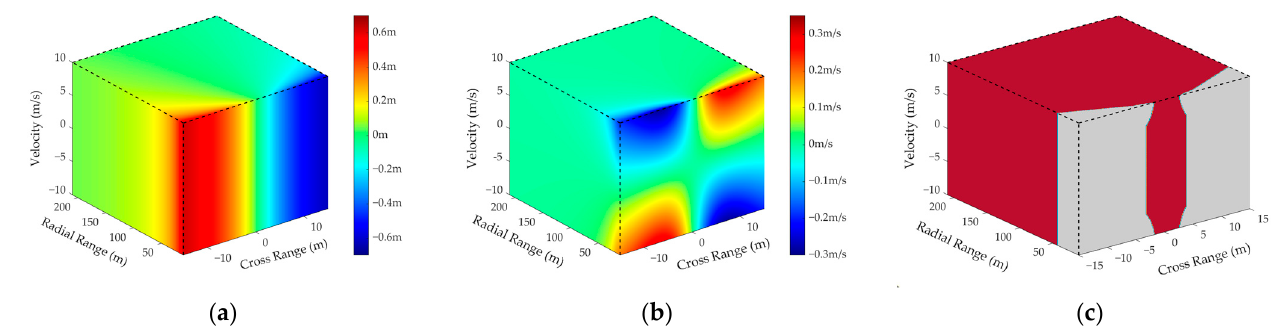
Figure 6. The simulation results of Test 1. ( a , b ) display the range and velocity deviations. ( c ) represents radar detection scenario, including effective region (red) and ineffective region (gray).